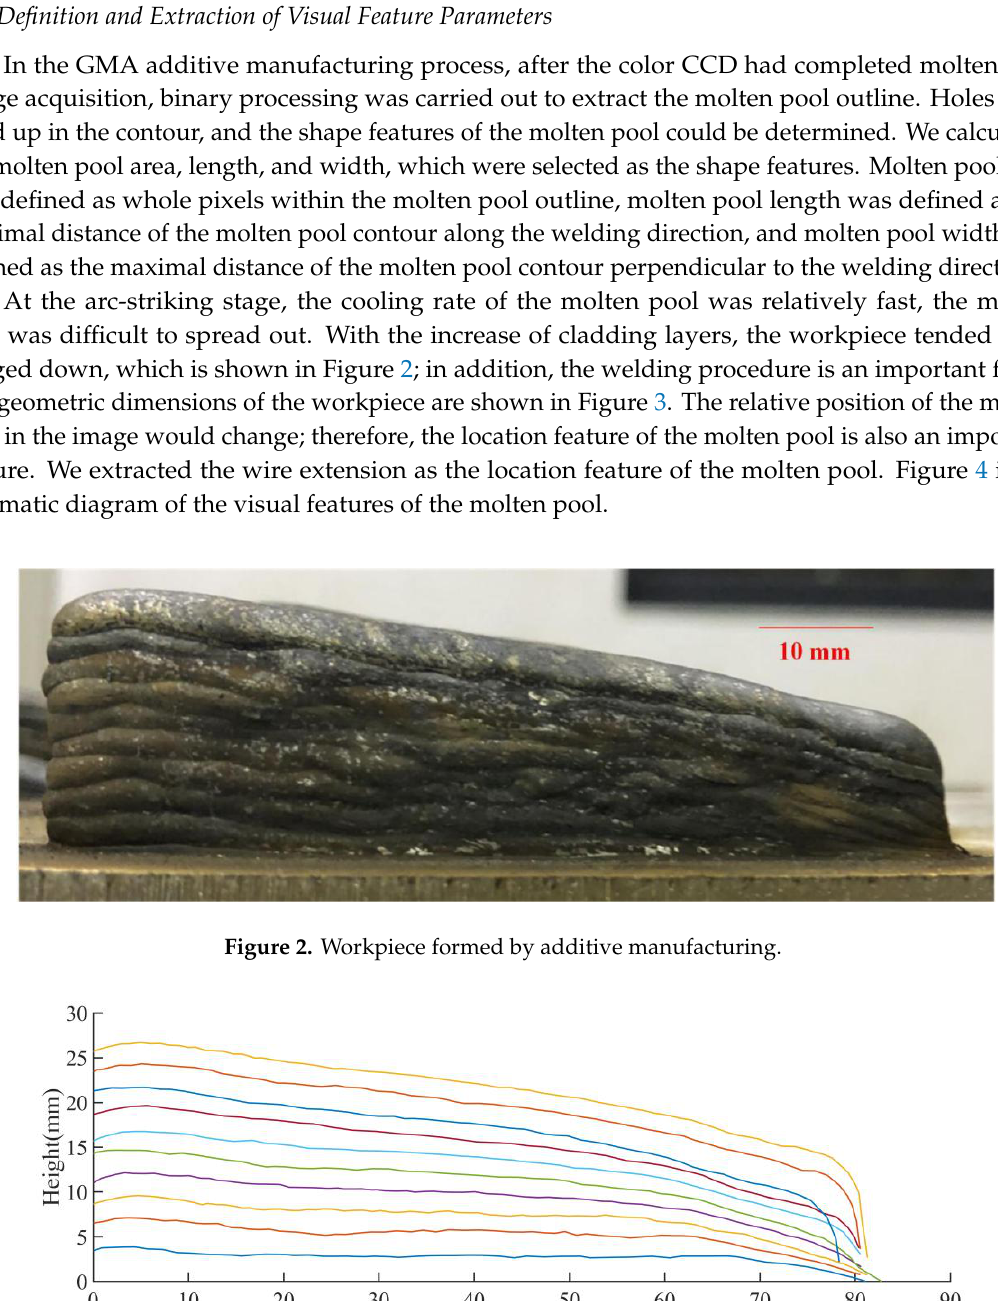
Table 2. Welding parameters.